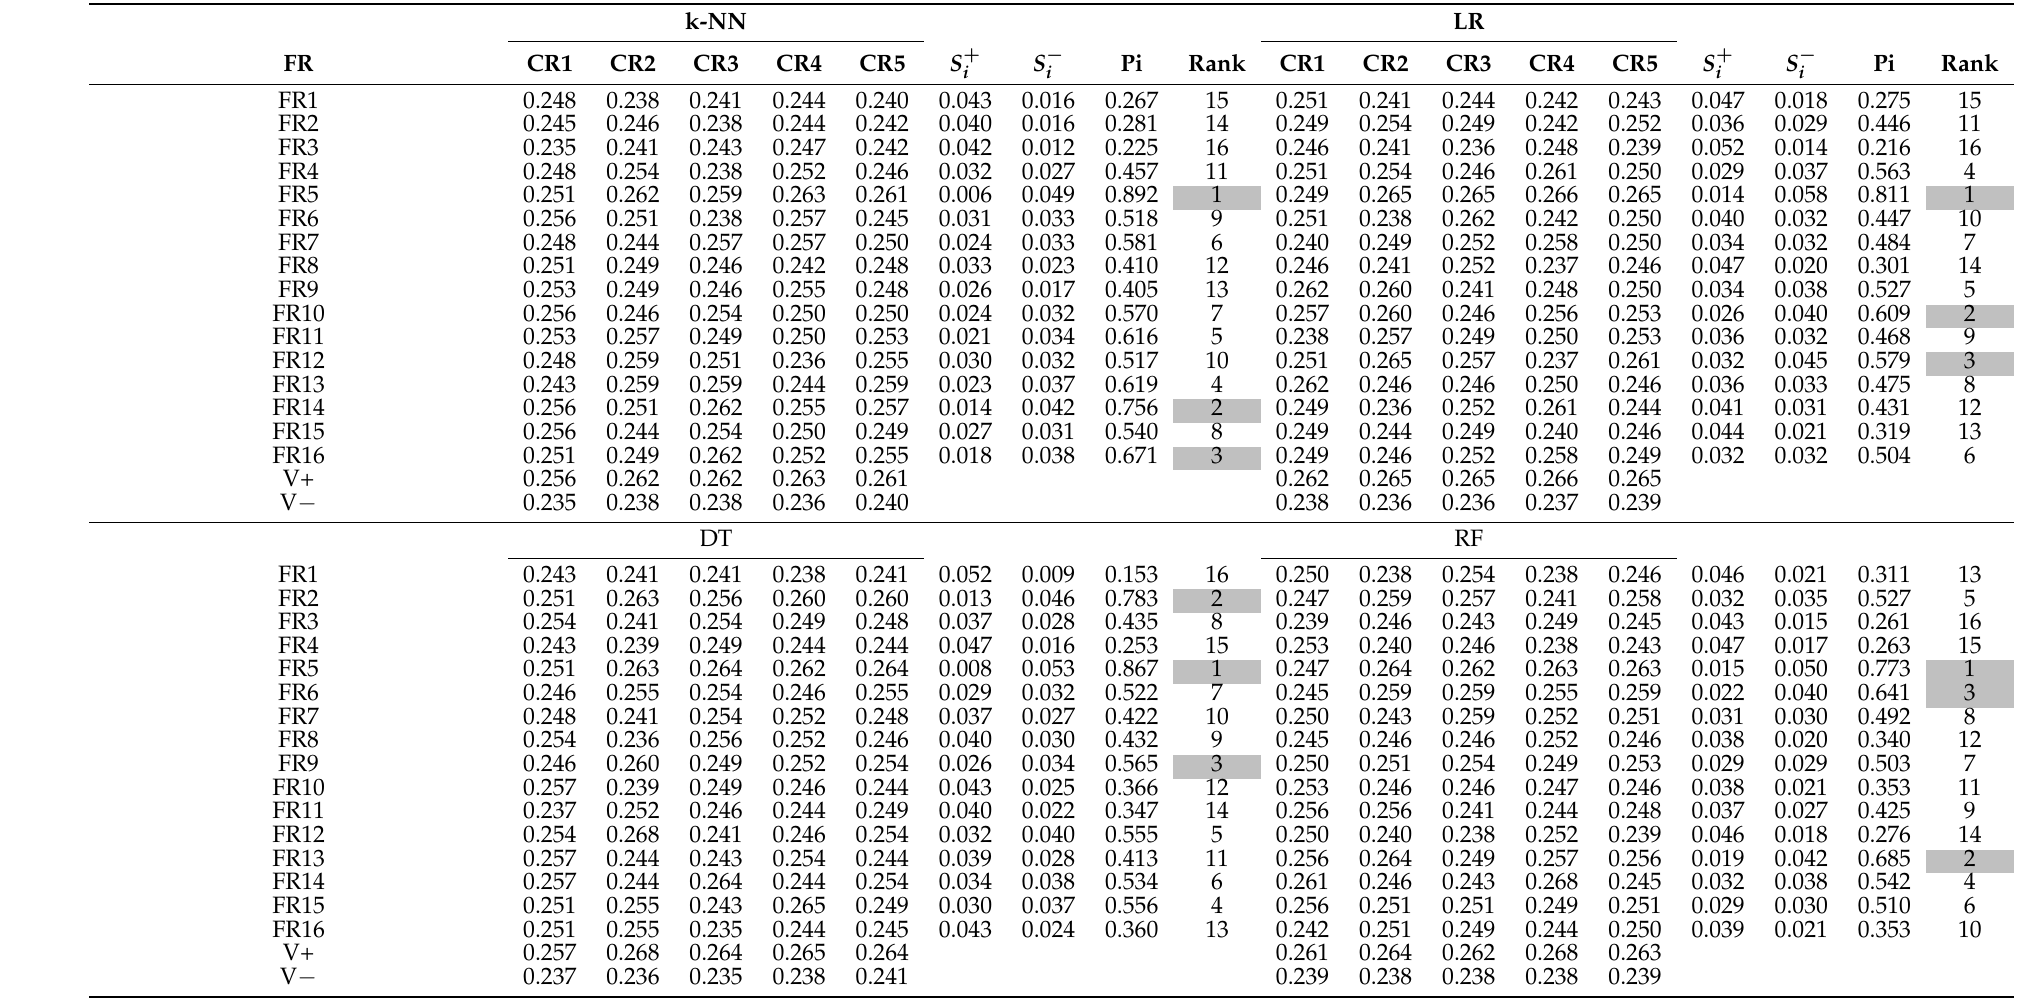
Table 7. Results of TOPSIS for Breast Cancer Dataset with Ranking of Feature Reduction Sequence using Dataset